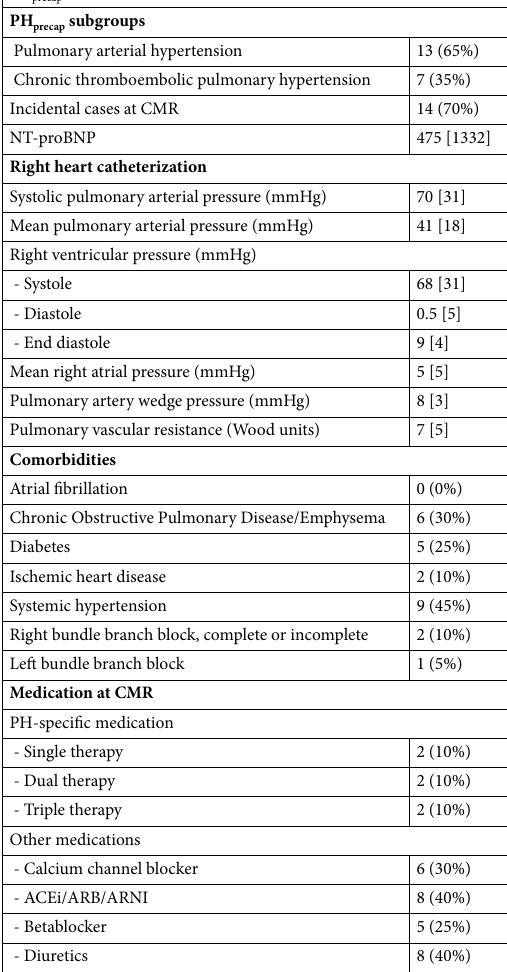
Table 1. Subject characteristics of patients with precapillary pulmonary hypertension. Data is expressed as median and interquartile range [IQR] or absolute numbers and proportion (%). ACEi, angiotensin-converting enzyme inhibitor; ARB, angiotensin receptor blocker; ARNI, angiotensin receptor-neprilysin inhibitor; CMR, cardiovascular magnetic resonance imaging; PH precap , precapillary pulmonary hypertension. PH-specific medication includes endothelin receptor antagonist, phosphodiesterase 5 inhibitor, prostaglandin analogue, selective prostacyclin receptor agonist, soluble guanylate cyclase stimulator.